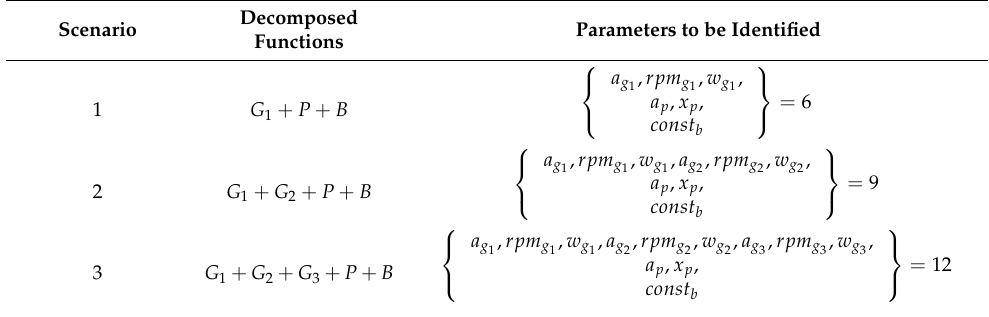
Table 1. Scenarios for model